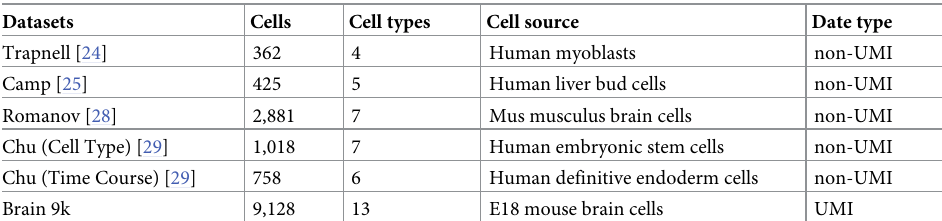
Table 1. A summary of the scRNA-seq